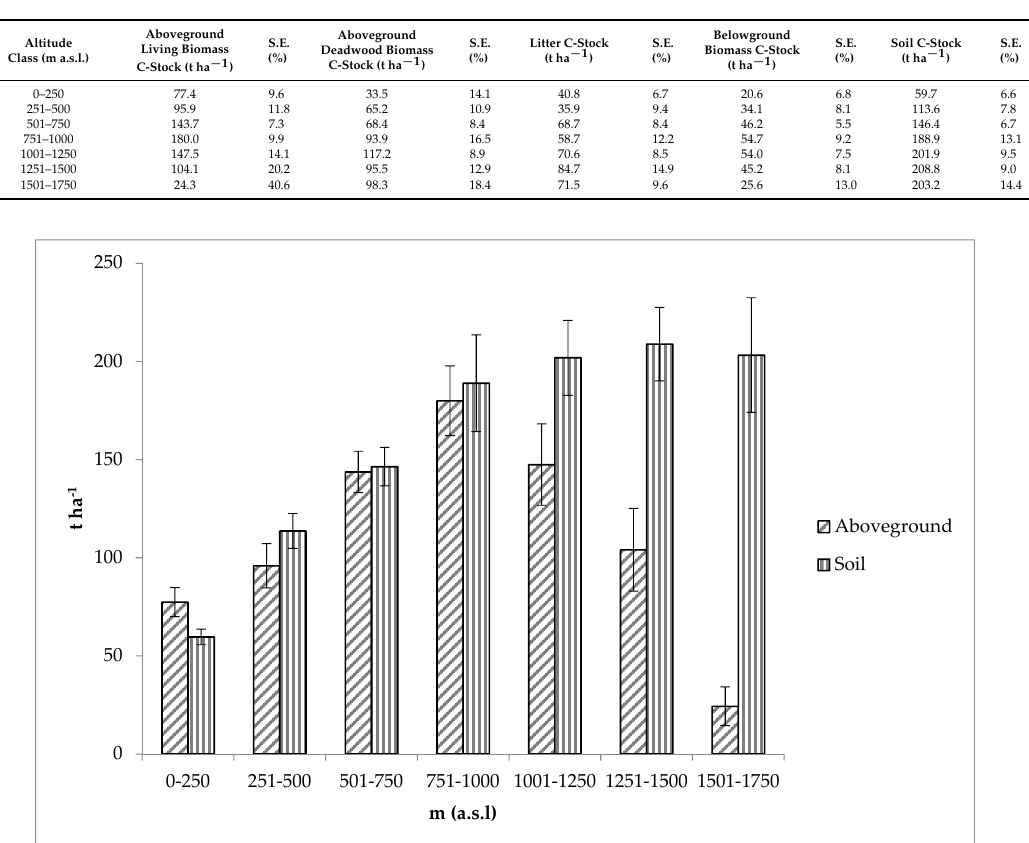
Table 5. Correlation matrix. Spearman correlation coefficients ( r ) between litter C ‐ stock and soil C ‐ stock and some site/stand features at the stratum level.